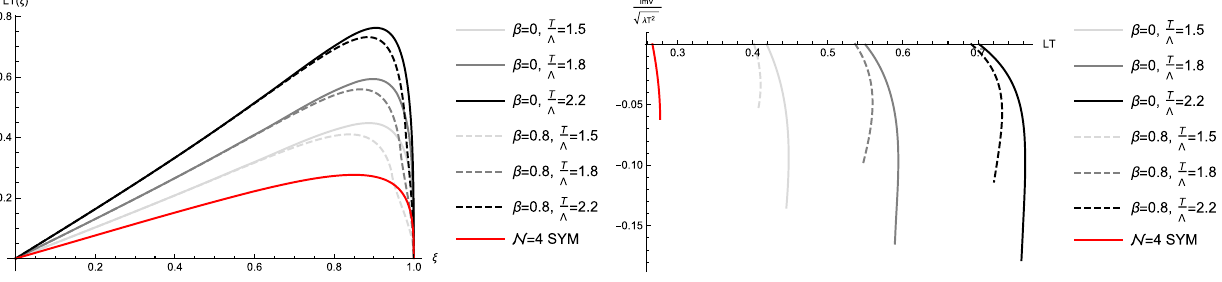
Fig. 4 The large black hole. Left: plot of LT versus ξ for different values of T /(cid:2) and β . Right: ImV T /(cid:2) and β